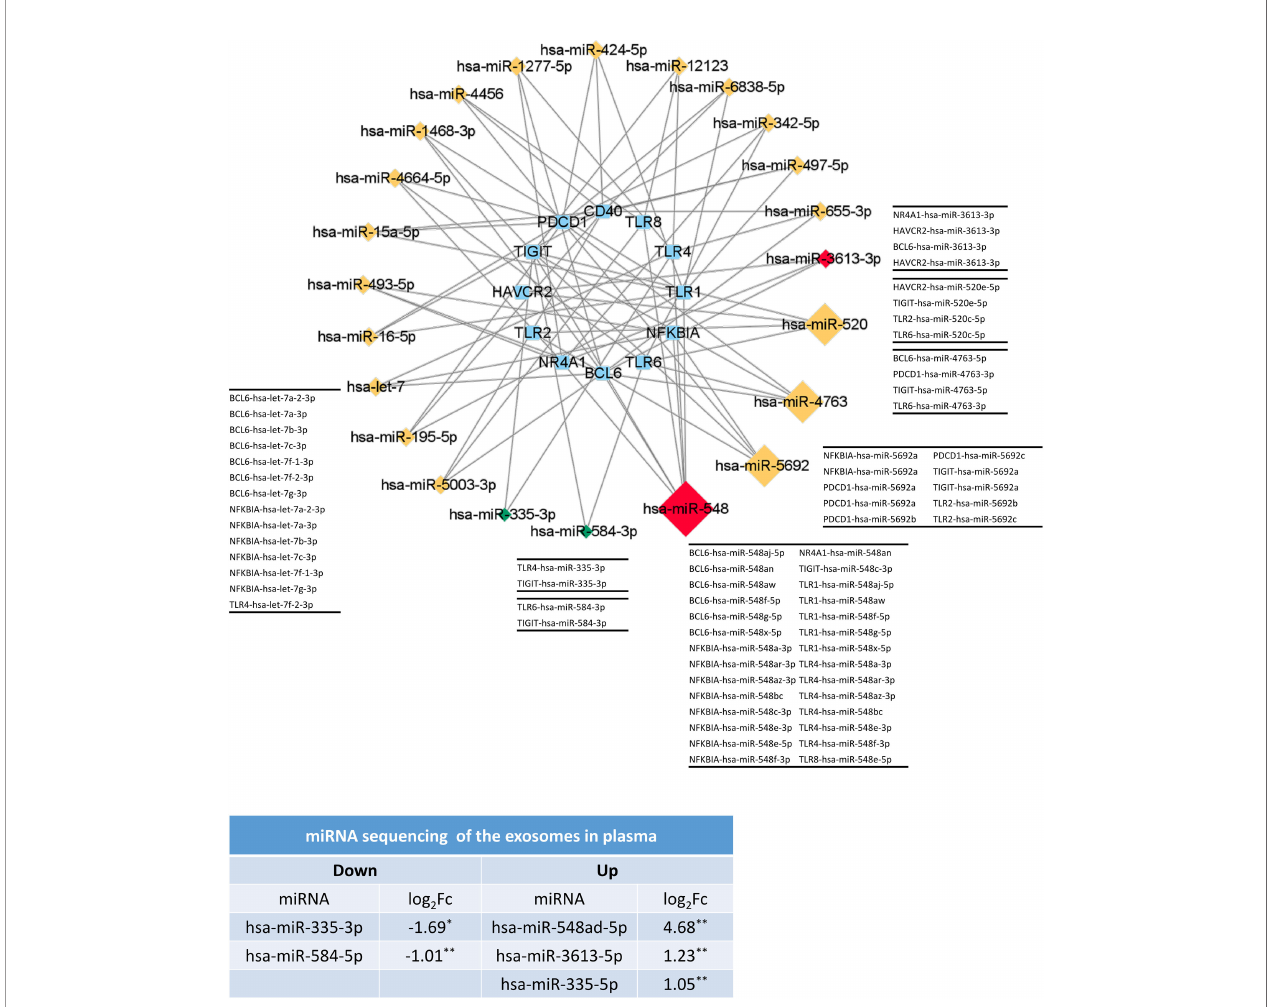
FIGURE 11 | The miRNAs might play an important role in the formation of TLRs-clustering at the inactive stage of TAK. The validation results of miRNA sequencing of plasma exosomes and the predicted miRNA-gene network (miRDB database) which only included the miRNA with a degree greater than or equal to 3 or the differentially expressed miRNA. Red and green colors of miRNA indicate upregulation and downregulation, respectively. Healthy controls, n=5 people. TAK patients, n=10 people. TAK, Takayasu ’ s